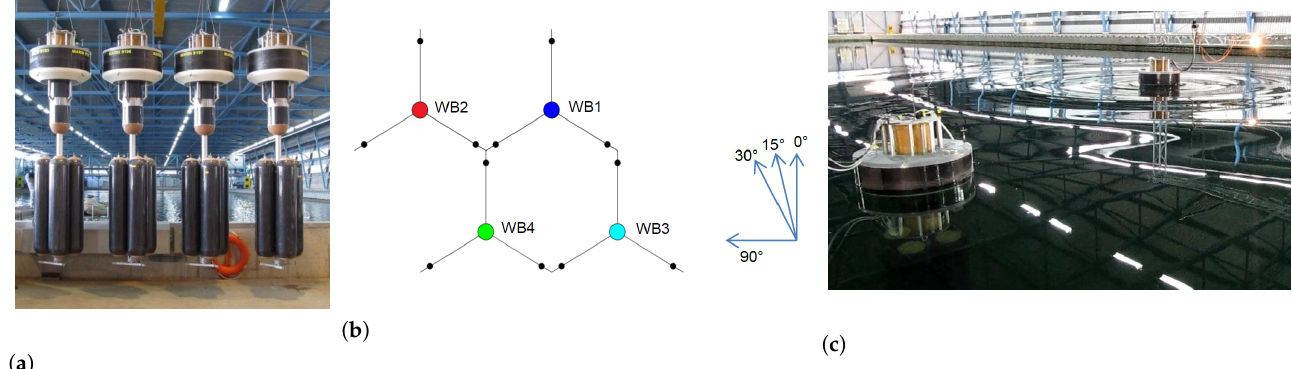
Figure 6. Experimental setup used by Mackay et al., reprinted with permission from Ref. [39], 2013,